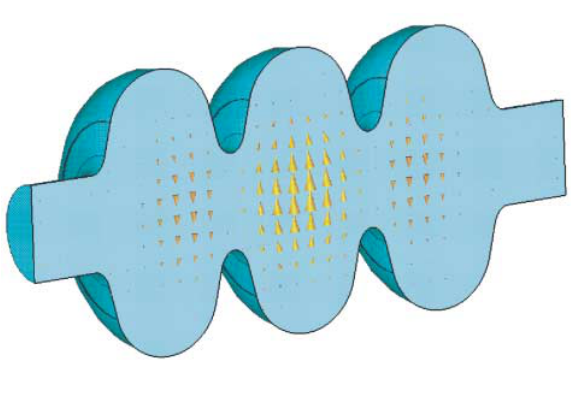
FIG. 8. (Color) Eigenmode in a three-cell cavity with resonance frequency f (cid:1) 3.0700 GHz (electric field).